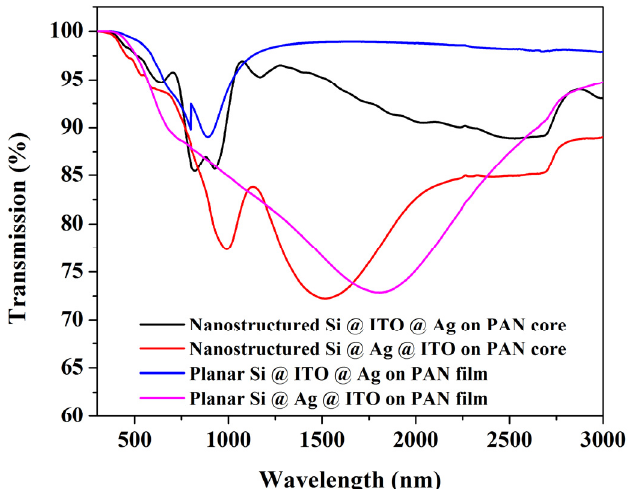
Figure 11. Transmission spectra of different sets of Si coated nanopillar